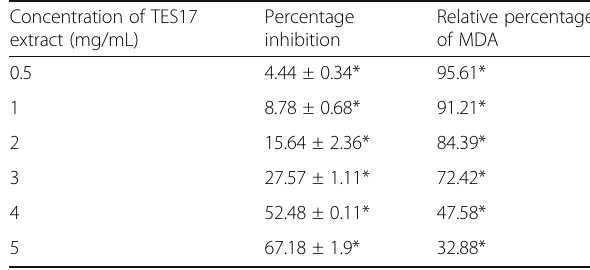
Table 4 Inhibition of lipid peroxidation and effect of TES17 extract on the MDA level in egg